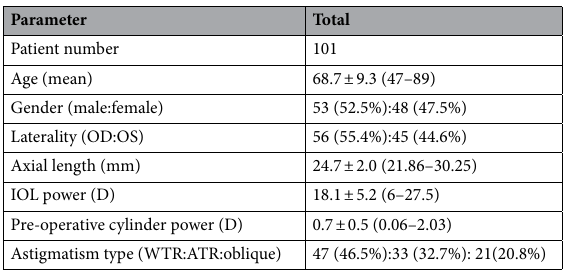
Table 1. Patient’s baseline characteristics. ATR against-the-rule, D diopters, IOL intraocular lens, OD right eye, OS left eye, WTR with-the-rule.